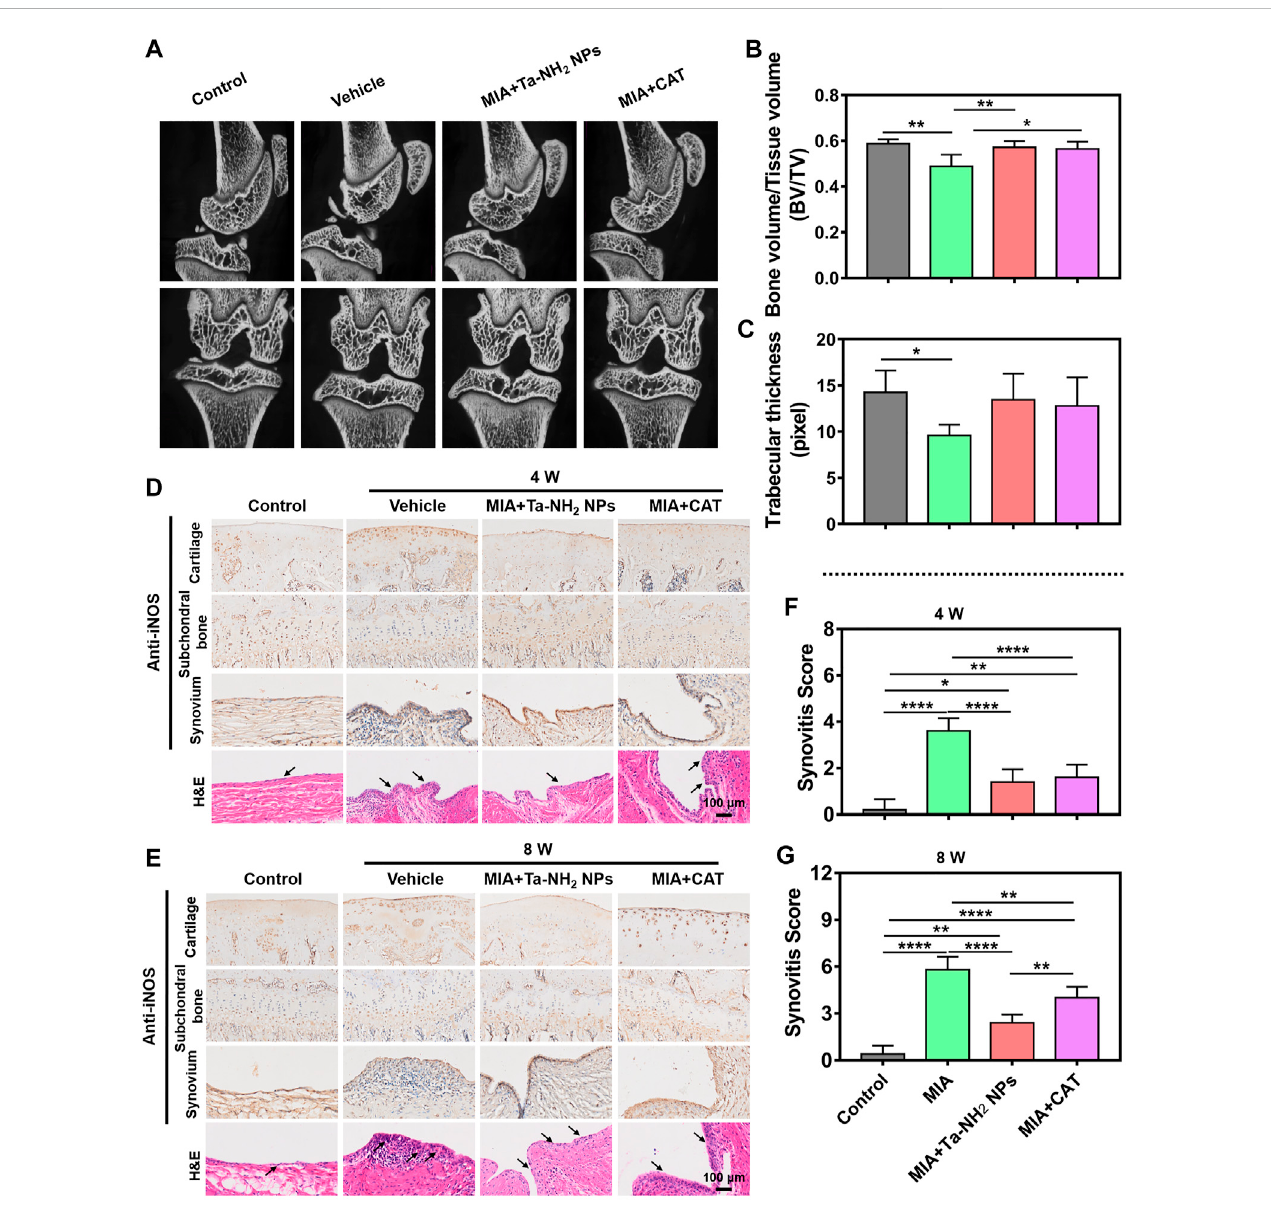
FIGURE 7 Ta-NH 2 NPs restored MIA-induced bone structure and alleviated the in fl ammation in synovium in rat model. (A) Micro-CT images of the MIA pretreated knee joints after single articular injection of Ta-NH 2 NPs or CAT. (B,C) Statistic analysis of Bone value/Tissue value and Trabecular thickness. (D,E) iNOS immunohistochemical and H&E staining of articular cartilage, subchondral bone, synovium and H&E staining of synovial tissue at 4 and 8 weeks post treatments. (F,G) Histopathological scoring of synovium at 4 and 8 weeks post treatments. The arrow points to the synovium and hyperplasia blood vessels. Data were represented as means ± s.d., from three or fi ve independent replicates (One-way ANOVA). * p < 0.05, ** p < 0.01, *** p < 0.001, **** p <